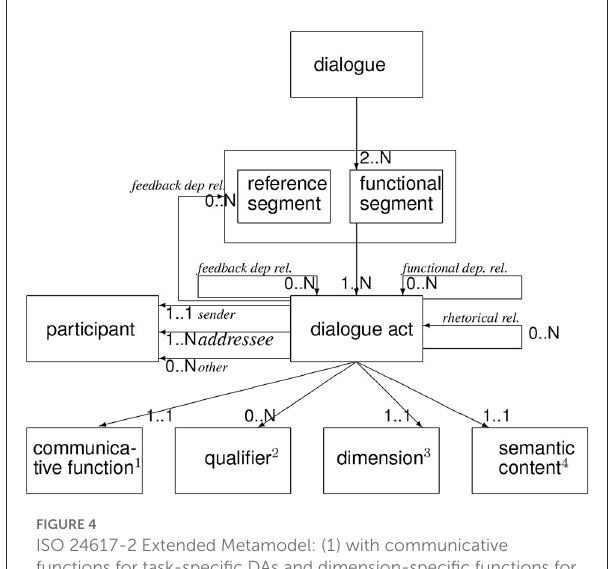
FIGURE4 ISO 24617-2 Extended Metamodel: (1) with communicative functions for task-specific DAs and dimension-specific functions for Task Management and IRM. (2) with additional qualifiers for emotions. (3) with additional dimension: Interpersonal Relations Management (IRM). (4) plug-in for articulate semantic content